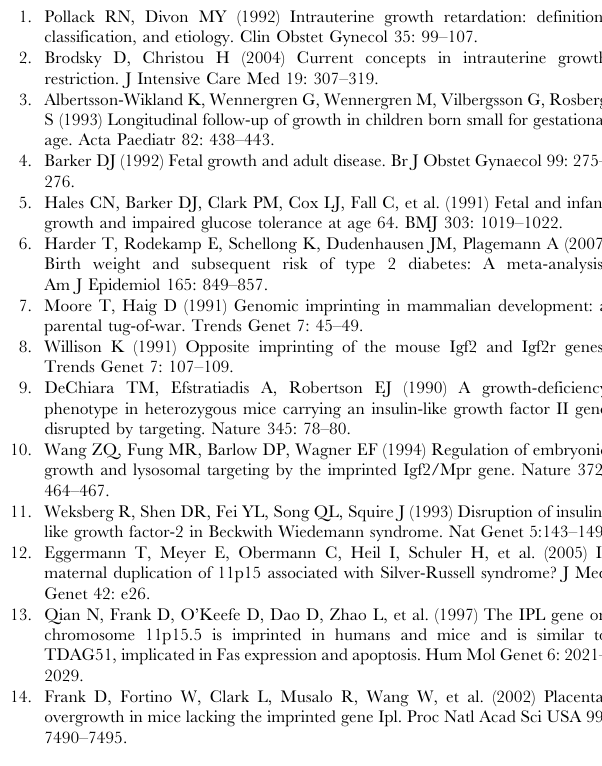
Figure S1 Confounding factors. Correlation of birth weight with gestational age at term (p= 4.8 6 10 2 15 ; Fig. S1A), with maternal BMI (p = 0.0012; Fig. S1B), with gender (p =1.4 6 10 2 7 ; Fig. S1C), with parity (p= 7.5 6 10 2 5 ; Fig. S1D), and maternal smoking status (p = 0.33; Fig